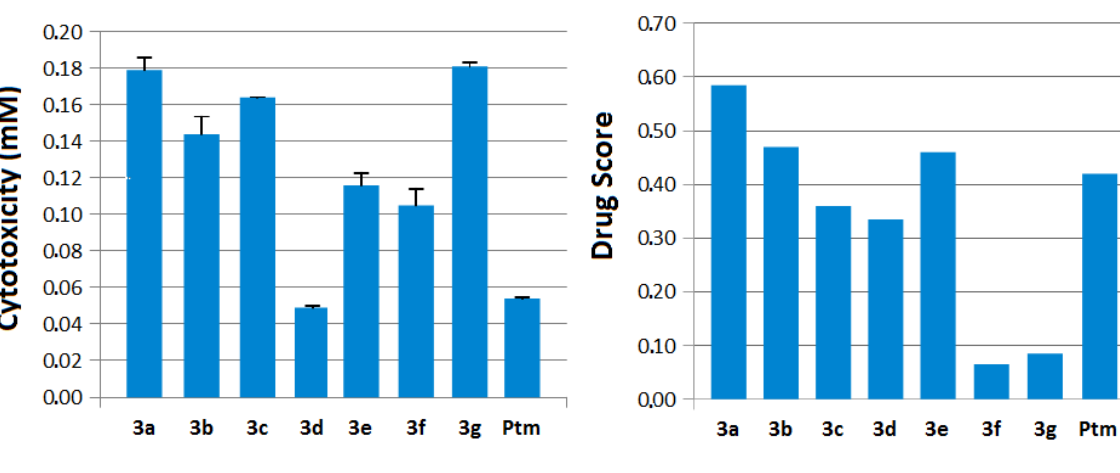
) using murine adherent peritoneal cells and Figure 1. The experimental cytotoxicity (CC 50 the theoretical drugscore values of the new 4-(1 H -pyrazol-1-yl)benzenesulfonamide